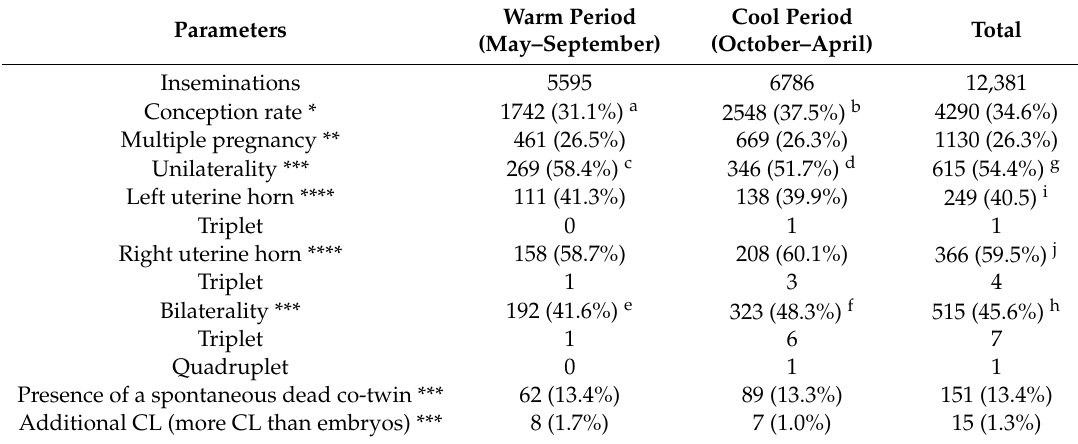
Table 1. Conception and multiple gestation patterns related to the presence of unilateral embryos (at least two embryos in the right or left uterine horn) or bilateral embryos (at least one embryo in each uterine horn) during the warm and cool periods 28–34 days post-artificial